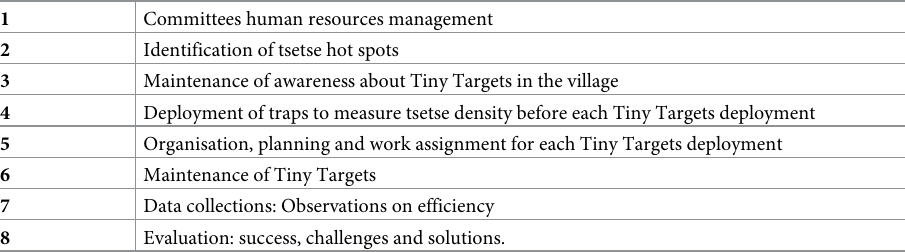
Table 2. Main responsibilities taken by the Vector Control Committees after